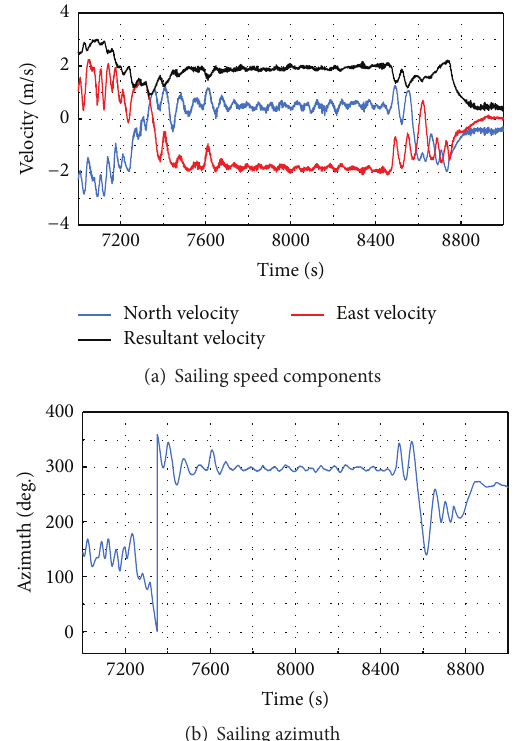
Figure 14: Sailing state in a short interval.